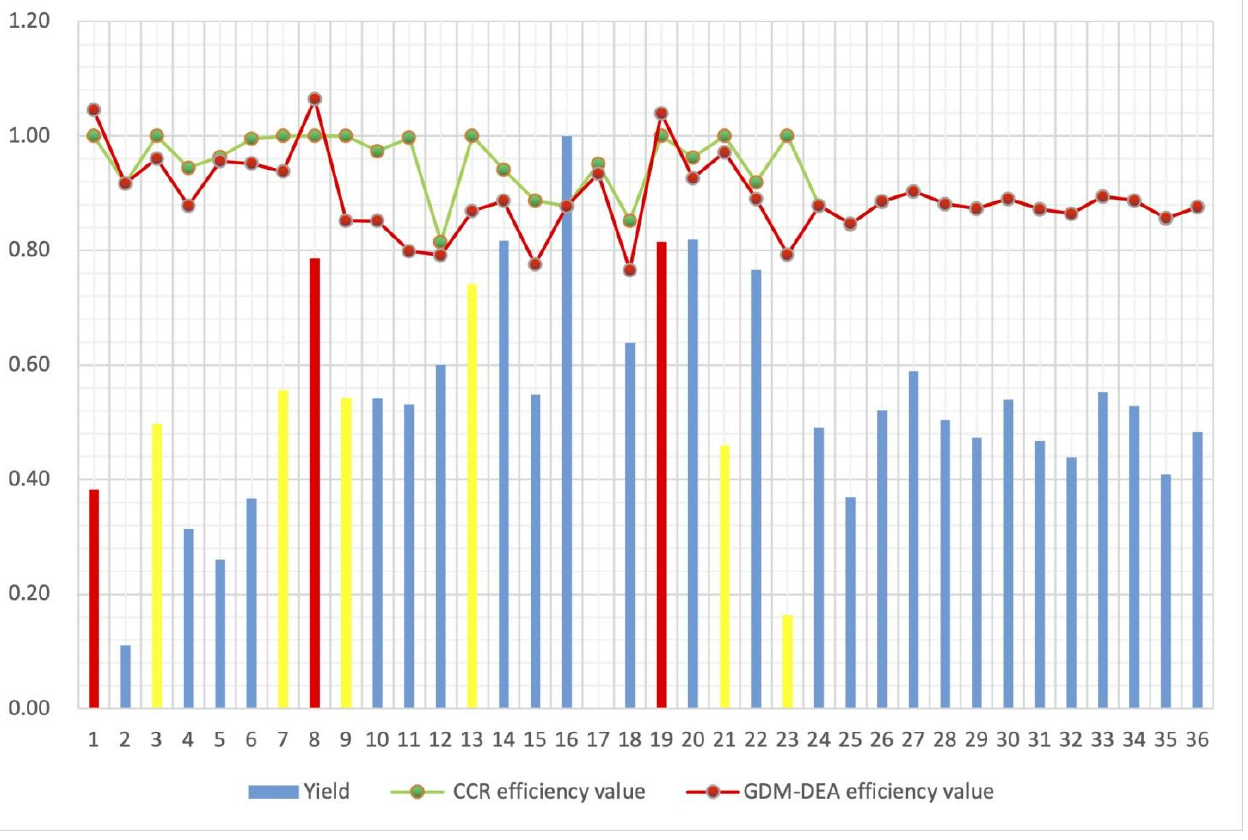
Figure 2. Output and efficiency analysis for the JLASTU experiment.